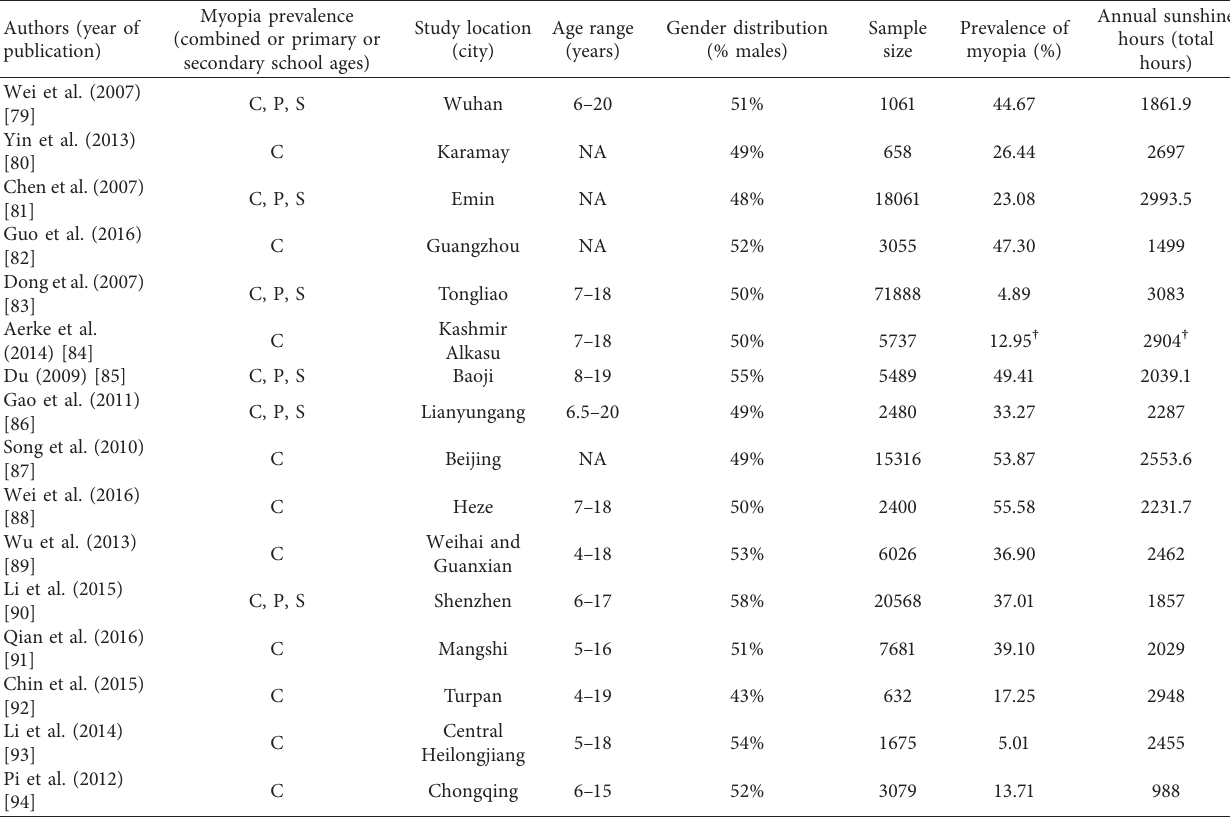
Table 2: Relationship between covariates and myopia prevalence from univariate metaregression analyses in all the studies (5–20 years),